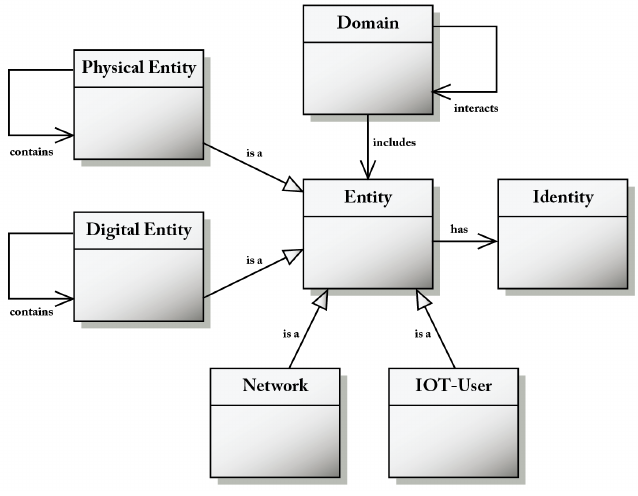
Figure 2. Entities of the IoT CM.